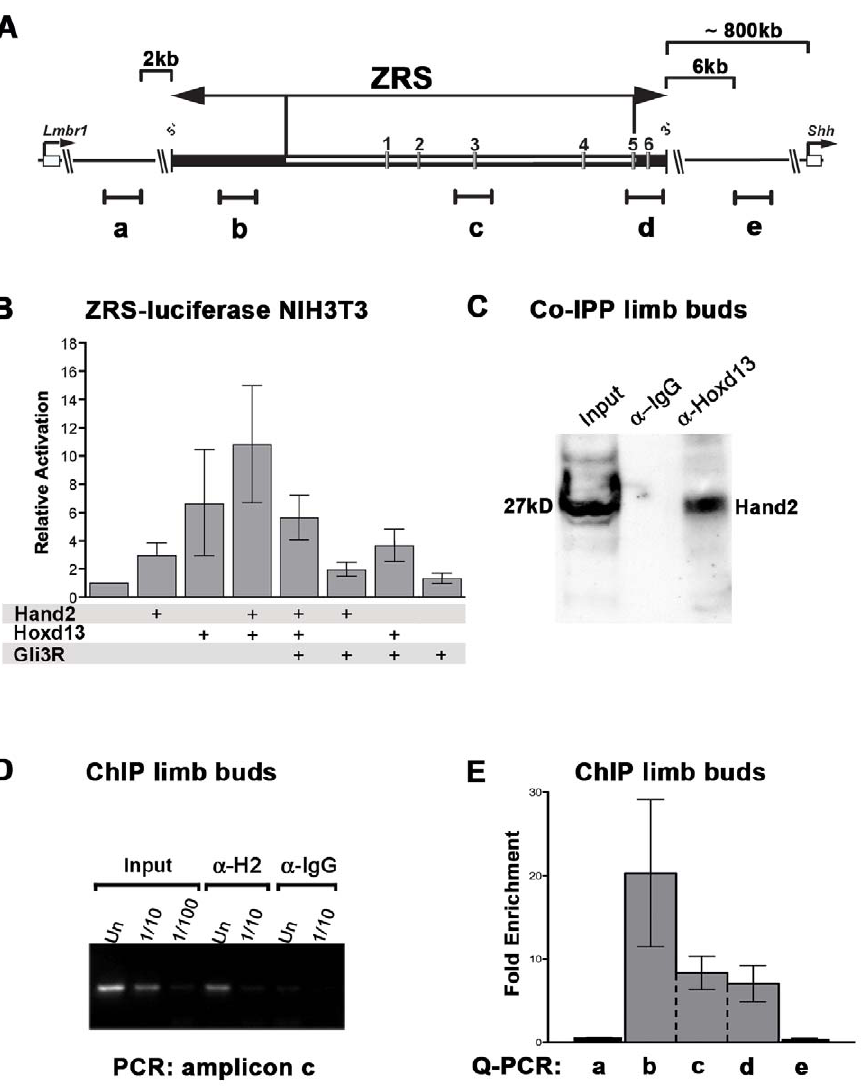
Figure 4. Hand2 interacts with Hoxd13 and is part of the chromatin complexes bound to the ZRS in limb buds. (A) Scheme of the , 1.7 kb mouse ZRS cis -regulatory and the flanking genomic regions. The ZRS is located within an intron of the mouse Lmbr1 gene (indicated on the left) and located , 800 kb upstream of the Shh proximal promoter and coding exons (indicated on the right, see also Figure S5). The evolutionary conserved ZRS region drives expression of a LacZ reporter gene in Shh -like pattern in mouse limb buds [28], while deletion of the MFCS1 core region (indicated in white) disrupts Shh activation in limb buds [29]. Six Ebox sequences in the ZRS, which could potentially interact with Hand2 proteins are numbered ‘‘1’’ to ‘‘6’’. Black lines indicate the approximate positions and sizes of the PCR amplicons for ChIP analysis. Note that amplicons ‘‘b’’ to ‘‘d’’ reside within the mouse ZRS, while amplicons ‘‘a’’ and ‘‘e’’ are located , 2 kb upstream and , 6 kb downstream of the ZRS and serve as non–ZRS controls. (B) Luciferase transactivation assay in NIH3T3 fibroblasts. Cells were co-transfected with ZRS-Luc and the expression plasmids indicated. Bars represent standard deviations. P , 0.0001 for all samples except Gli3R alone: P=0,0519. (C) Co-immunoprecipitation of Hand2 and Hoxd13 from wild- type limb buds (E10.5) using anti-Hoxd13 antibodies ( a -Hoxd13) or IgGs (control). Hand2 proteins associated to Hoxd13 protein complexes were detected by Western blotting. (D,E) ChIP from wild-type limb buds (E11.0) to detect Hand2-containing chromatin complexes bound to the ZRS. (D) Analysis of amplicon ‘‘c’’ by conventional PCR (186 bp). Input: DNA isolated from cross-linked chromatin of E11.0 limb buds prior to ChIP was used as a positive control for PCR amplification. a -H2: ChIP using Hand2 antibodies. a -IgG: ChIP using non-specific goat IgGs as a control. Un: undiluted sample; dilutions as indicated. (E) Q–PCR analysis of three completely independent ChIP experiments using freshly cross-linked chromatin and a - Hand2 antibodies. The average values 6 standard error are shown. Values obtained by amplifying a particular region from ChIP experiments using non-specific goat IgGs were arbitrarily set at 1 and used to calculate the values for the a -Hand2 ChIP experiments. Statistical evaluation by the Mann- Whitney test shows that the amplicons within the ZRS (‘‘b’’ to ‘‘d’’) are enriched in a statistically highly significant manner in comparison to the adjacent non-ZRS amplicons (‘‘a’’ and ‘‘e’’;